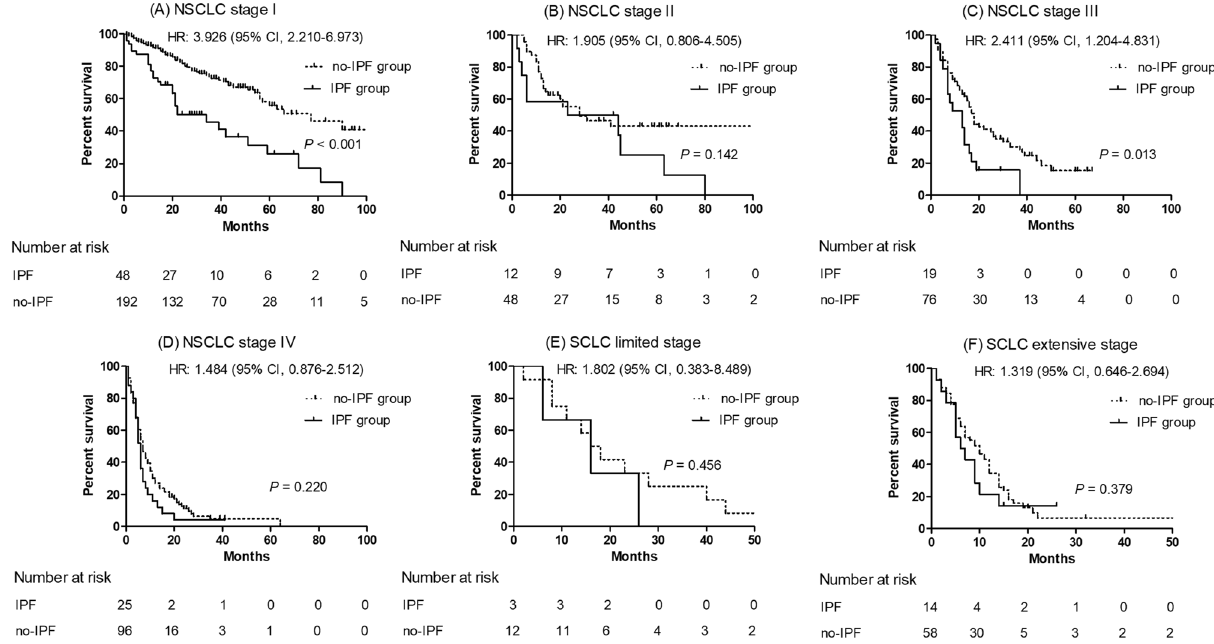
Figure 2. Comparison of survival curves between the IPF and no-IPF groups among patients with lung cancer. ( A ) NSCLC stage I, ( B ) NSCLC stage II, ( C ) NSCLC stage III, ( D ) NSCLC stage IV, ( E ) SCLC limited stage, and ( F ) SCLC extensive stage. NSCLC non-small cell lung cancer, SCLC small cell lung